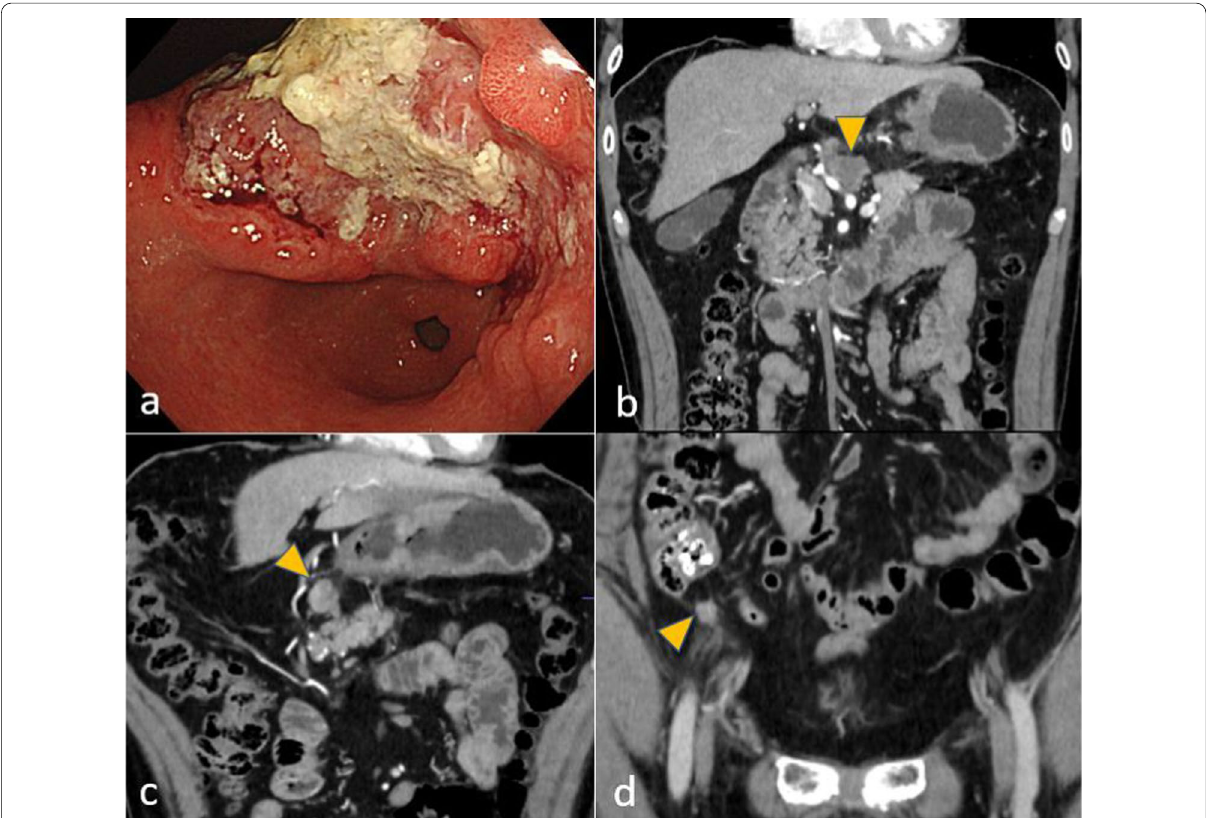
Fig. 3 Findings of case 2 with gastrointestinal endoscopy and abdominal computed tomography before treatment. a A type 3 tumor in the lesser curvature of the upper to lower gastric body was found. b – d Enlarged station No. 6 and 8a lymph nodes and peritoneal metastasis near the cecum (arrowhead) were found